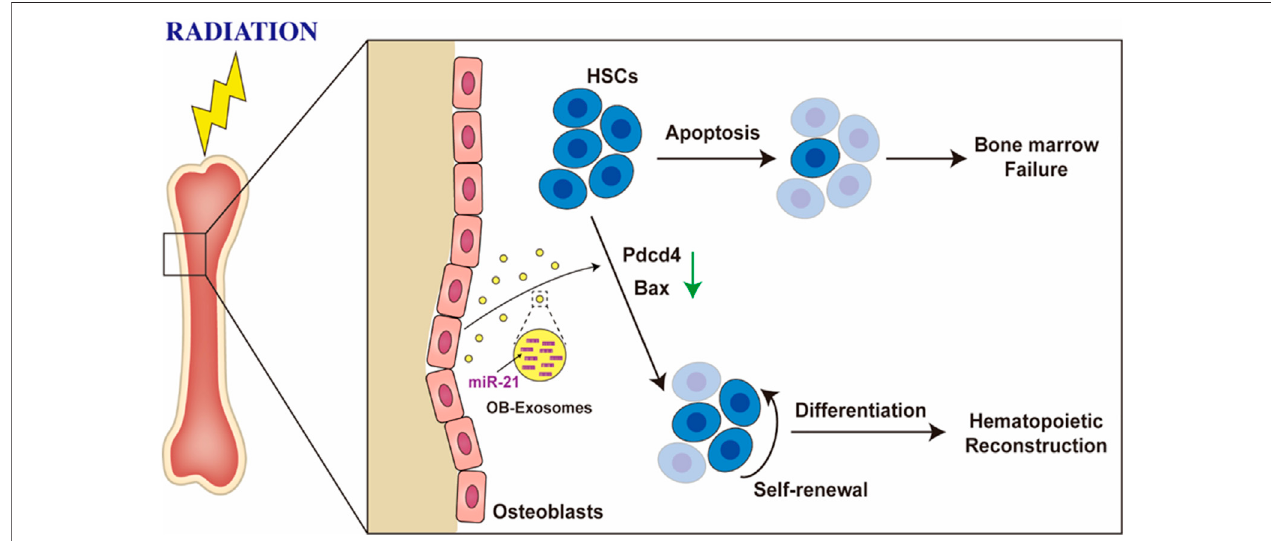
FIGURE6| Osteoblastderivedexosomesinhibitradiation-induceddamagetohematopoieticstemcell.OB-exosomesledtoarecoveryofhematopoieticstemand progenitor cells numbers in vivo which decreased after total body irradiation, and signi fi cant improvement was observed in radiated mice injected with OB-exosomes. The miR-21 of OB-exosomes was identi fi ed as the target mediated the effect on the apoptosis of